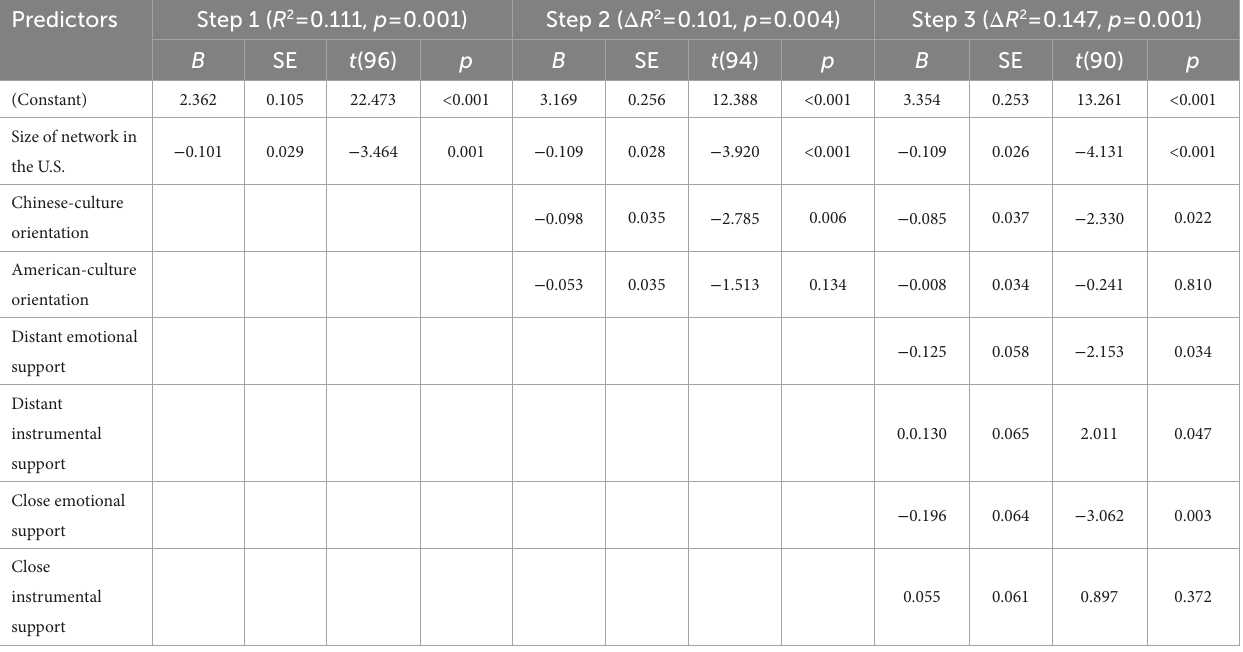
TABLE 7 Results of hierarchical regression analysis predicting loneliness in the